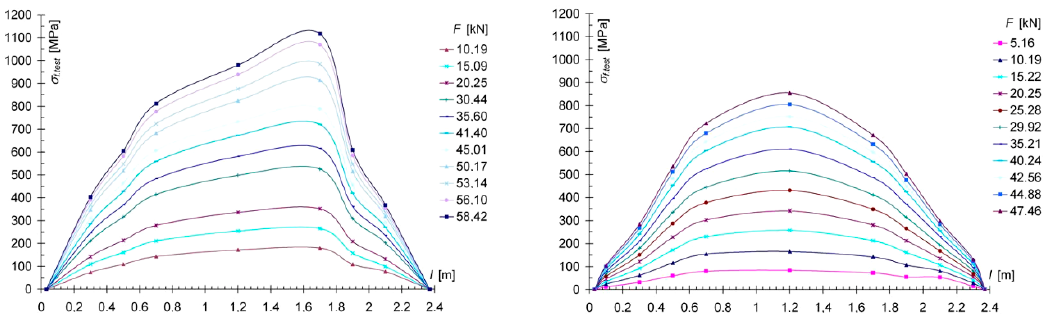
Figure 14. Comparison σ f.test —l of stress distribution in the CFRP tape for the SW-2.4H/1( a ) and the SW-2.4H/3( b ) models.